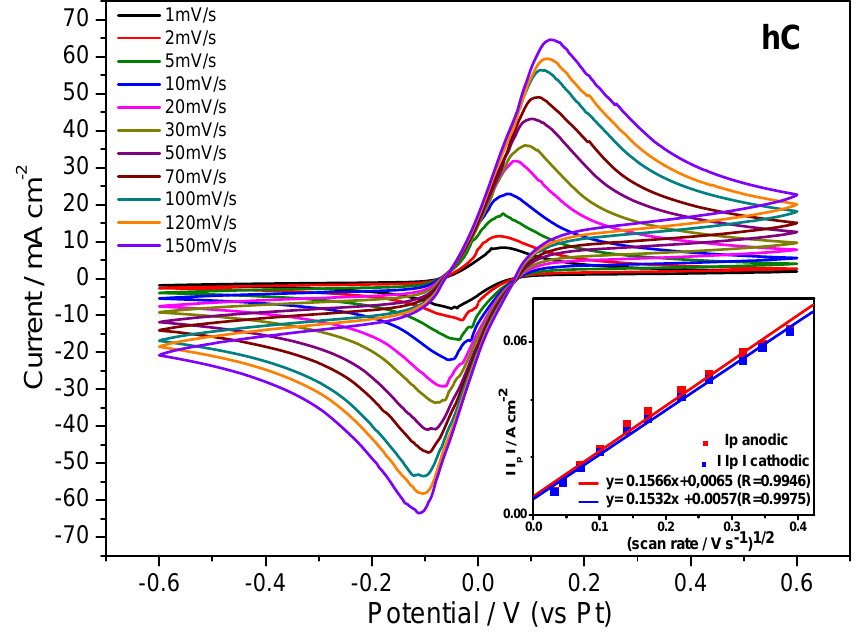
Figure 10. Cyclic voltammetry tests on hC swelled at RT in 0.25M K 4 [Fe(CN) 6 ]3H 2 O/ K 3 [Fe(CN) 6 ] aqueous solution registered at different scan rates, and (INSET) the plot of peak current density vs. square root of potential scan